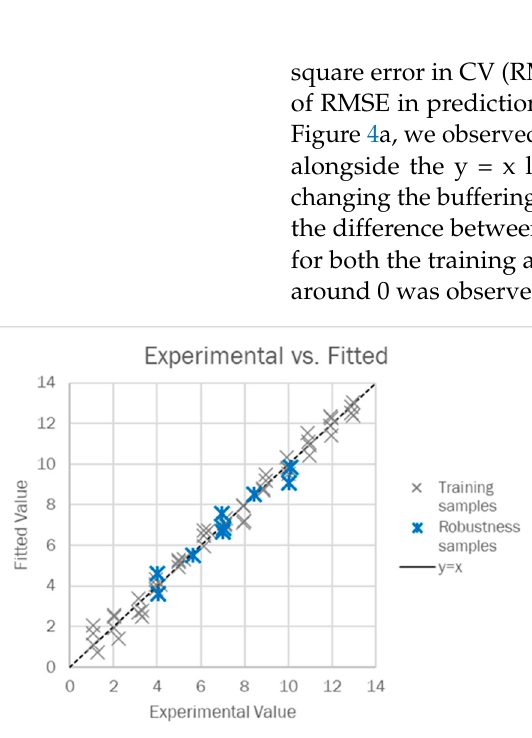
Table 4. pH range, correspondent training samples, candidate Dye-EVOH@ sensors, and % ex- plained variance for pH ranges A, B, and C.